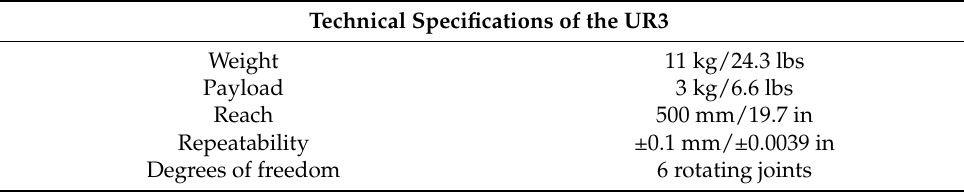
Table 1. Specifications of the UR3 CB-series.